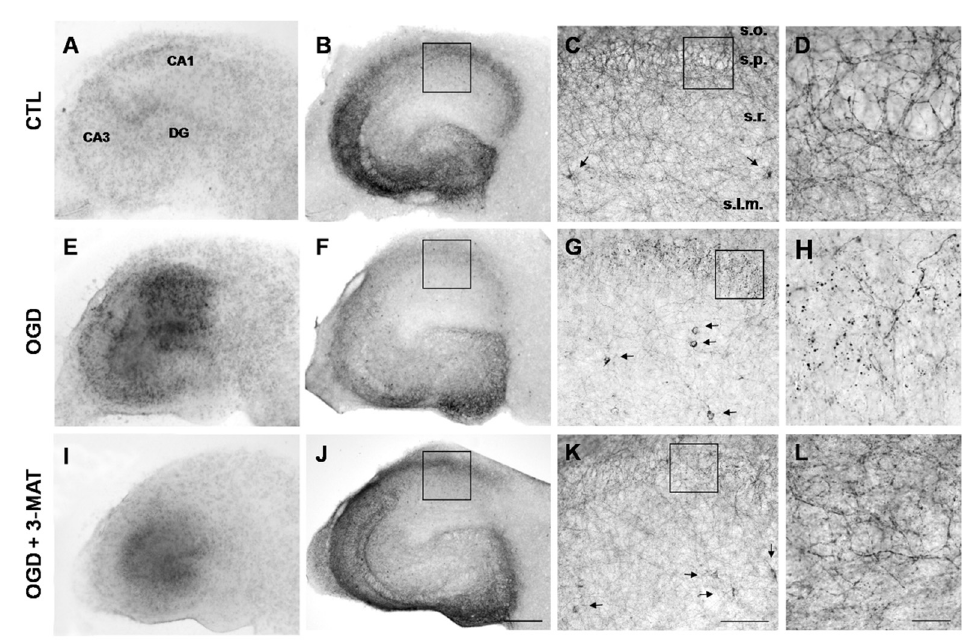
Figure 4. CB1 receptor expression in organotypic hippocampal slices exposed to OGD. ( A , E , I ) Bright-field transmission images of organotypic hippocampal slices displaying CA1 injury 24 h after 30 min OGD and neuroprotection with the mGlu1 antagonist 3-MATIDA (3-MAT, 100 µM). ( B , F , J ) CB1-like immunoreactivity in neurons of all hippocampal areas. OGD produces 24 h later a reduction of the dense plexus of immunolabeling mainly in CA1, that is prevented by 3-MATIDA. ( C , G , K ) Higher magnification of frames depicted in B-F-J displays an intense network of CB1-positive processes in stratum pyramidalis (s.p.) that is severely damaged by OGD and protected by 3-MATIDA. Conversely, isolated stratum radiatum (s.r.) CB1-positive interneurons (arrows) are not affected by OGD. ( D , H , L ) Higher magnification of frames depicted in ( C , G , K ) displays dramatic disruption of the CB1-like immunoreactive perisomatic axonal meshwork in stratum pyramidalis that is partially prevented by 3-MATIDA. Scale bars: 400 µm in ( A , E , I , B , F , J ), 100 µm in ( C , G , K ) and 20 µm in ( D , H , L ). Other abbreviations: s.o., stratum oriens; s.l.m., stratum lacunosum molaeculare.